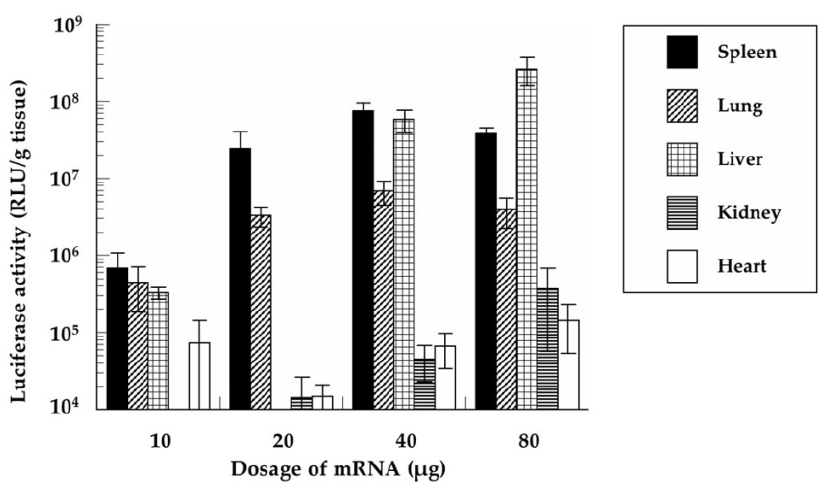
Figure 10. Protein expression of the mRNA/PEI8/ γ -PGA12 complex in mice after the intravenous administration of various doses of mRNA. At 24 h following administration, the luciferase activities of the liver, kidney, spleen, heart, and lung were determined by chemiluminescence. Data represent the mean ± S.E. ( n =